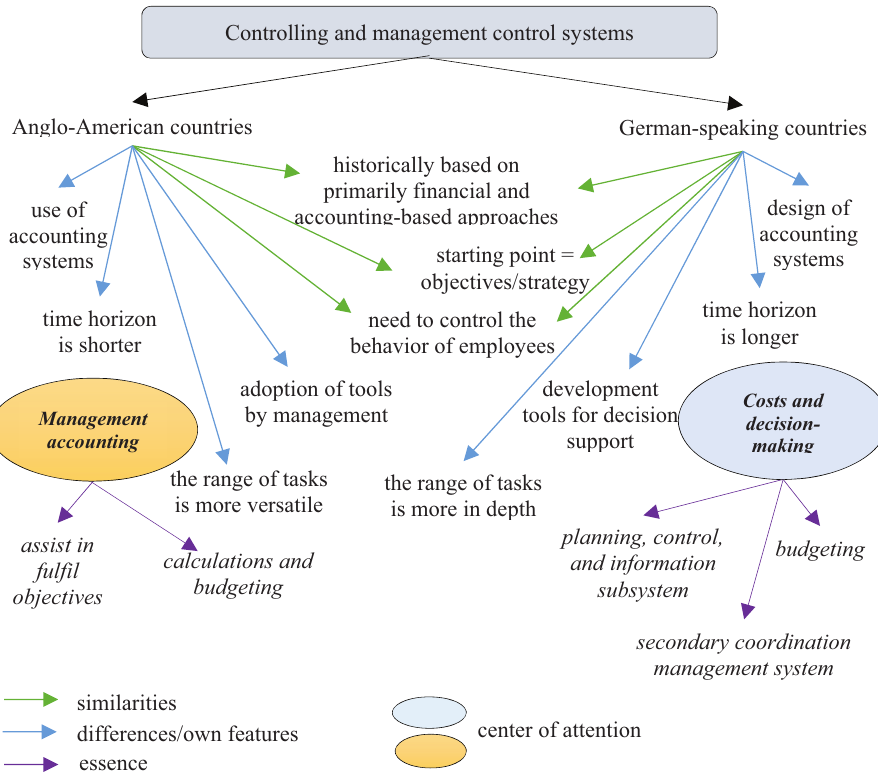
Figure 1. The basis of the term controlling in Anglo-American and German-speaking countries (source: own processing according to Guenther, 2013; White & Cokins,